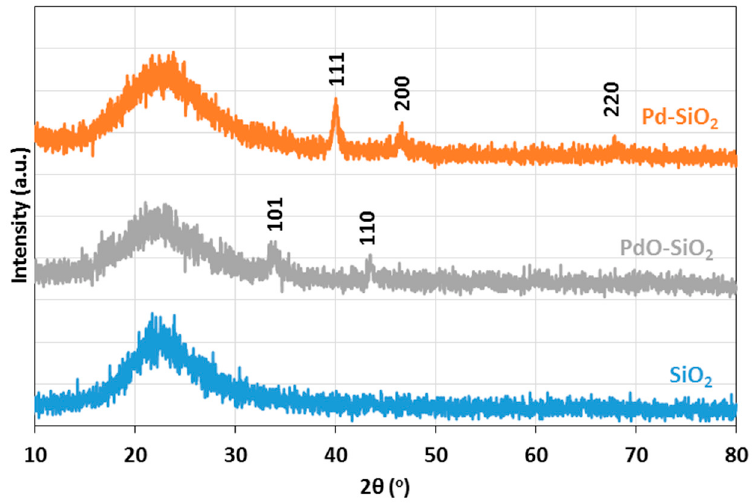
Figure 1. The XRD pattern of the bare SiO 2 , the as-synthesized PdO-SiO 2 , and the final solid Pd-SiO 2 samples.